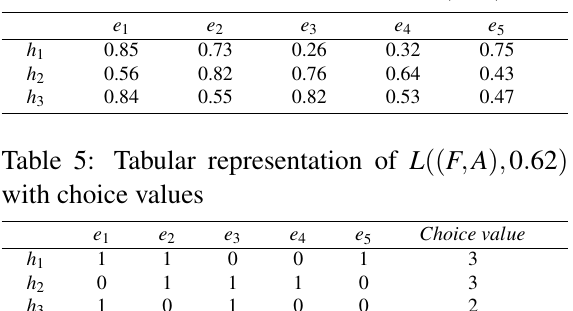
Table 2: Tabular representation of ( F , A ) e 1